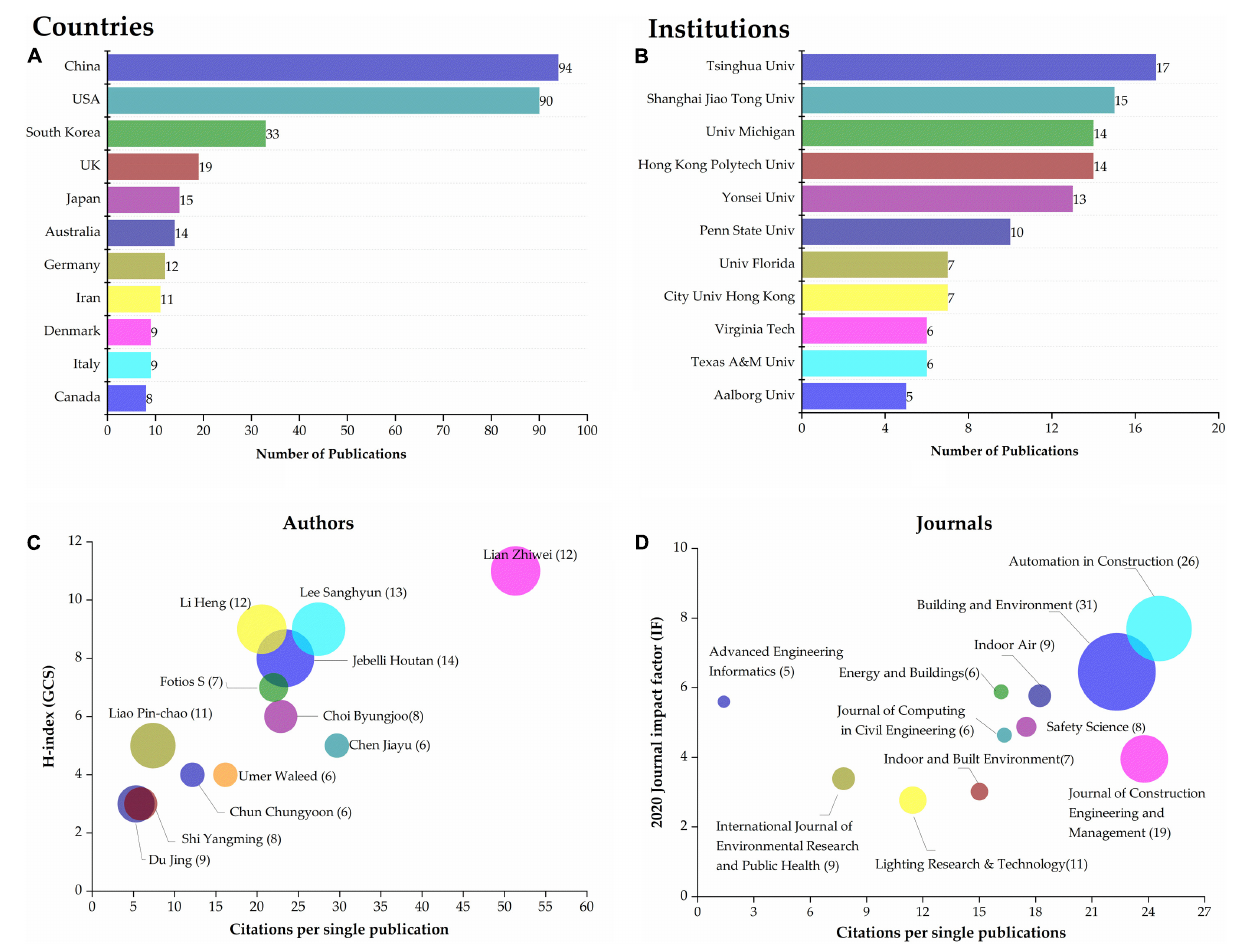
FIGURE 4 | Country analysis (A) , institution analysis (B) , author analysis (C) , and journal analysis (D) of publication in this